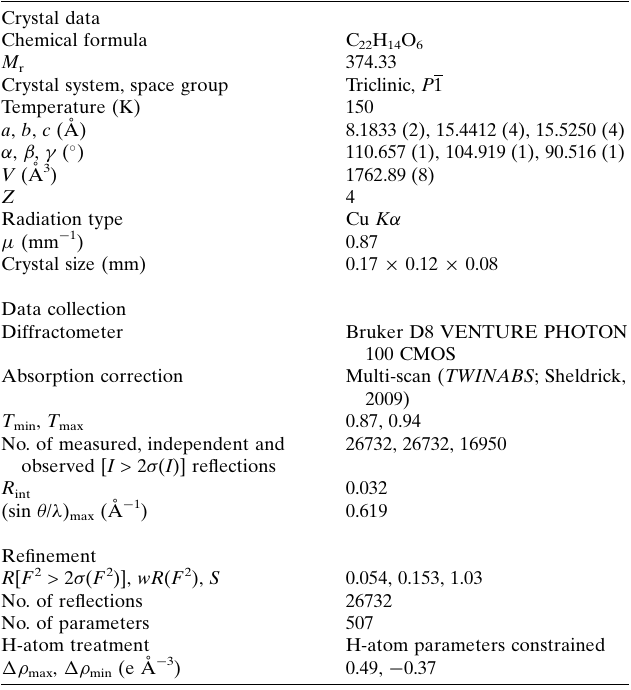
Table 2 Experimental details.